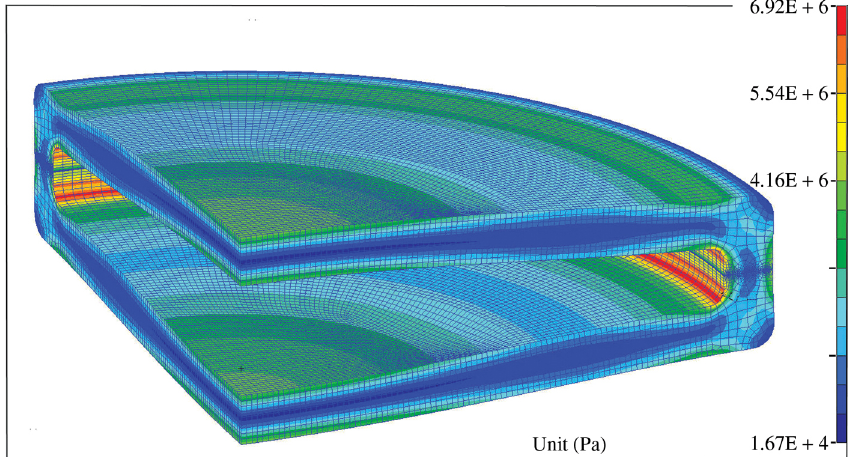
Figure 19: Stress distribution of the closed vase form during stress figuring. The maximum tensile stress arises along the internal round corners of the elliptical rings with σ = 6.92 MPa. For Schott-Zerodur this value is much smaller than max the ultimate strength σ = 51 MPa for a 1-month loading time duration [4]. One may notice that at the symmetry plane the epoxy link reduces σ to ≃ 1